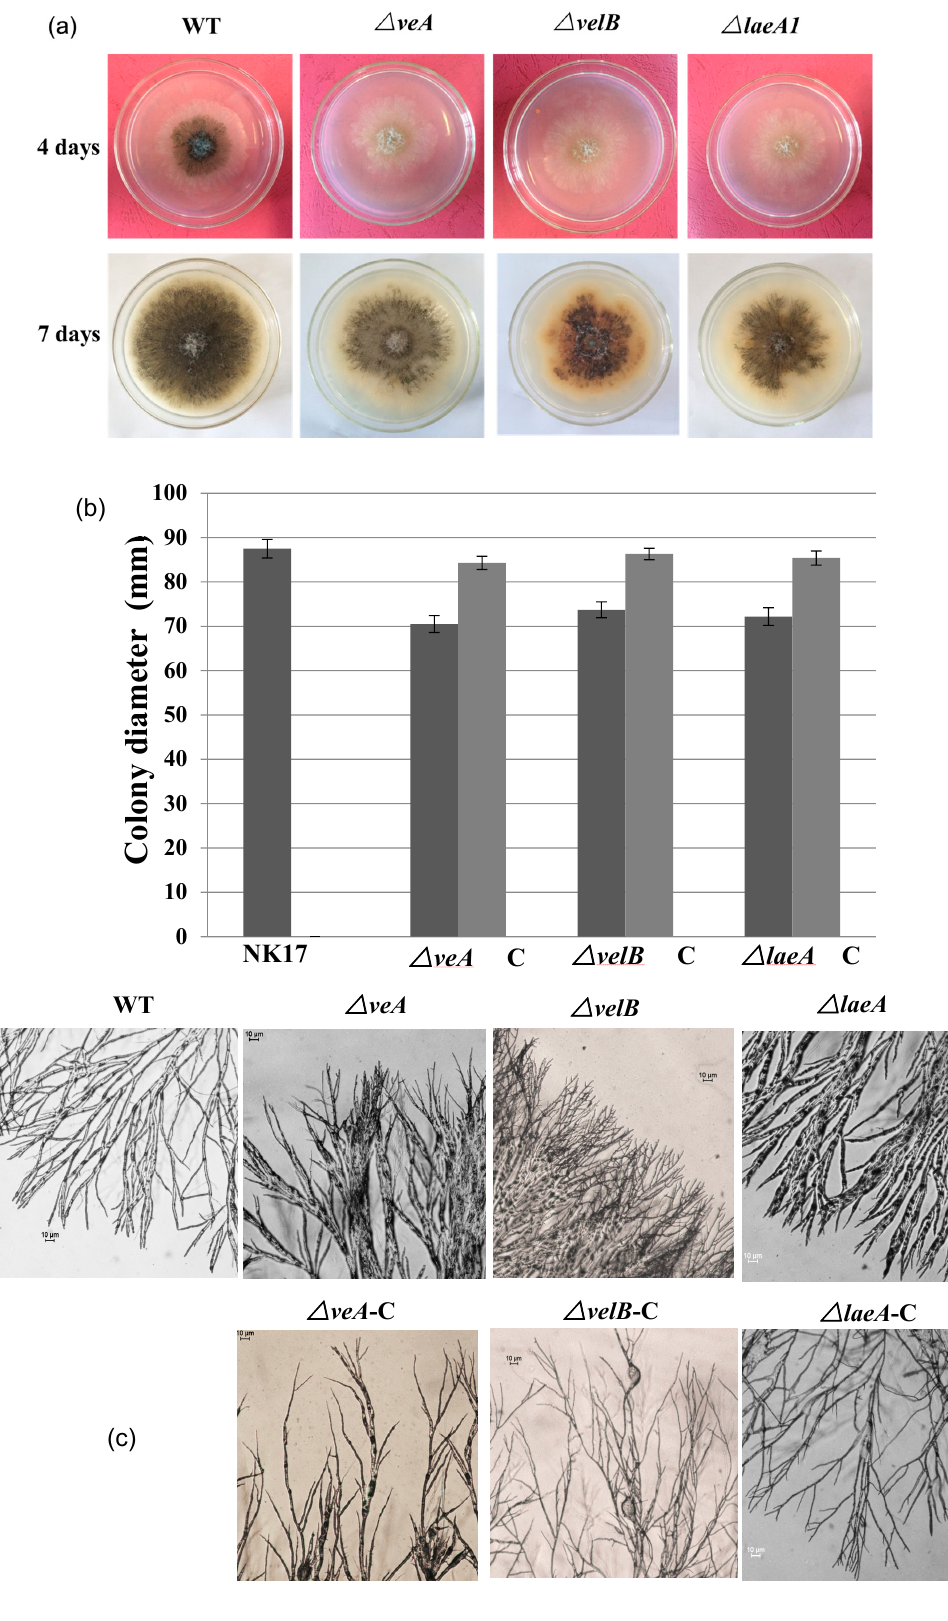
Figure 2. Cont. Figure 2.